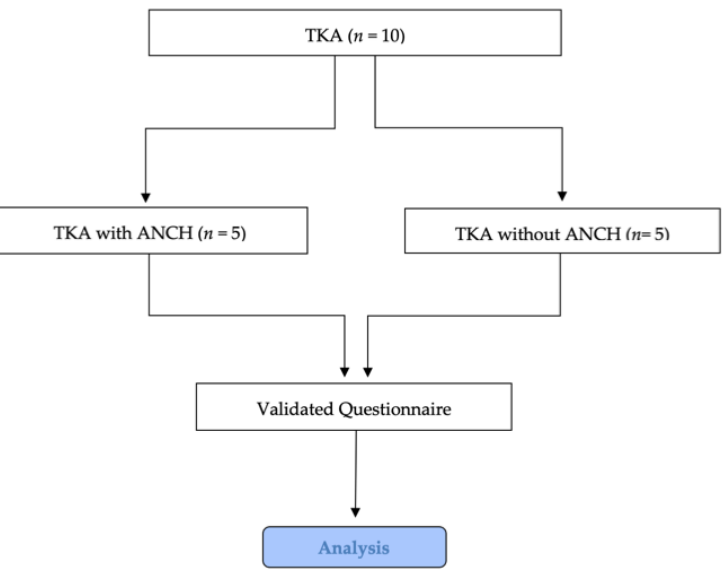
Figure 1. Flowchart showing the study design. TKA: Total Knee Arthroplasty; ANCH: Active Noise Cancelling Headphones.